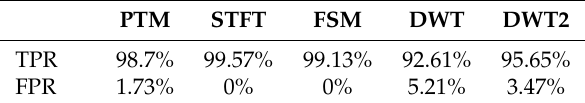
Figure 11. ROC of step counting: personalization. Table 8. Step counting: Foot.